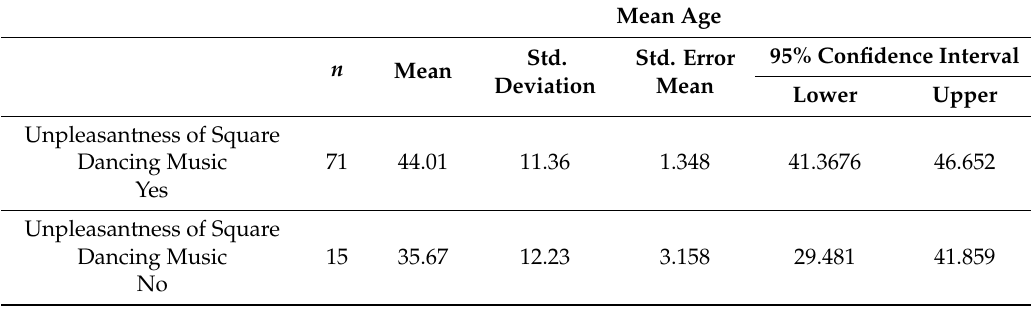
Table 6. Two-Sample t test with unequal variances comparing Mean Age with unpleasantness of square dance music.